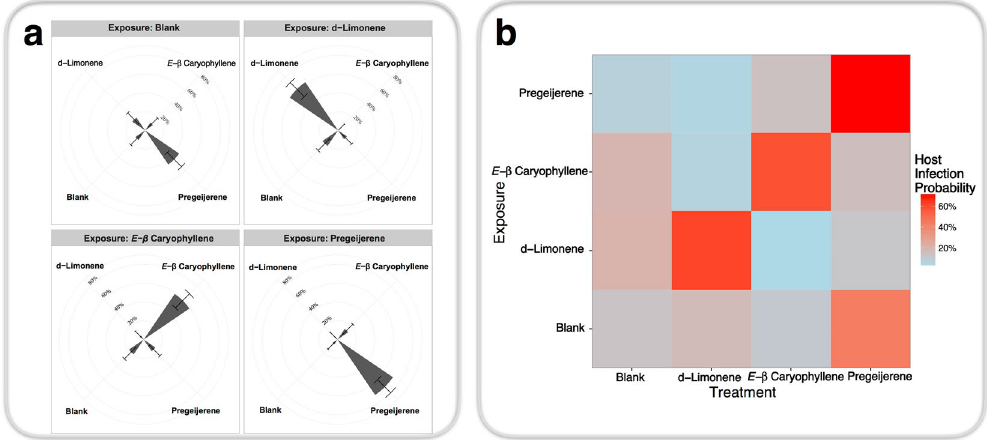
Figure 2. Parasitoid Learning Affects Host Infection. Prior exposure to belowground volatiles affects entomopathogenic nematode infection of larvae of the weevil D . abbreviatus , a natural host. ( a ) Cohorts of entomopathogenic nematode infective juveniles were exposed to blank controls and three common belowground plant volatiles then assayed in four-arm, sand-filled olfactometers where they responded to D . abbreviatus larvae paired with those volatiles. Concentric circles indicate host infection probability. Wedges and error bars denote host infection probability and ninety-five percent confidence intervals respectively. ( b ) Prior exposure to belowground volatiles increases host infection probability when host is paired with exposed